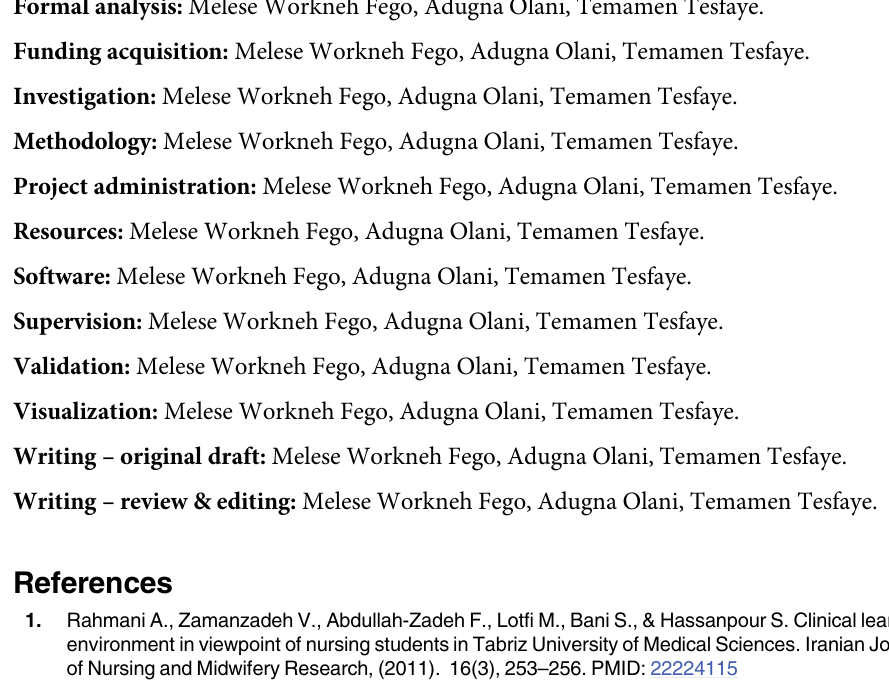
S1 Table. Themes emerged, categories, and codes of nursing students’ in governmental Universities of southwest Ethiopia, (n =